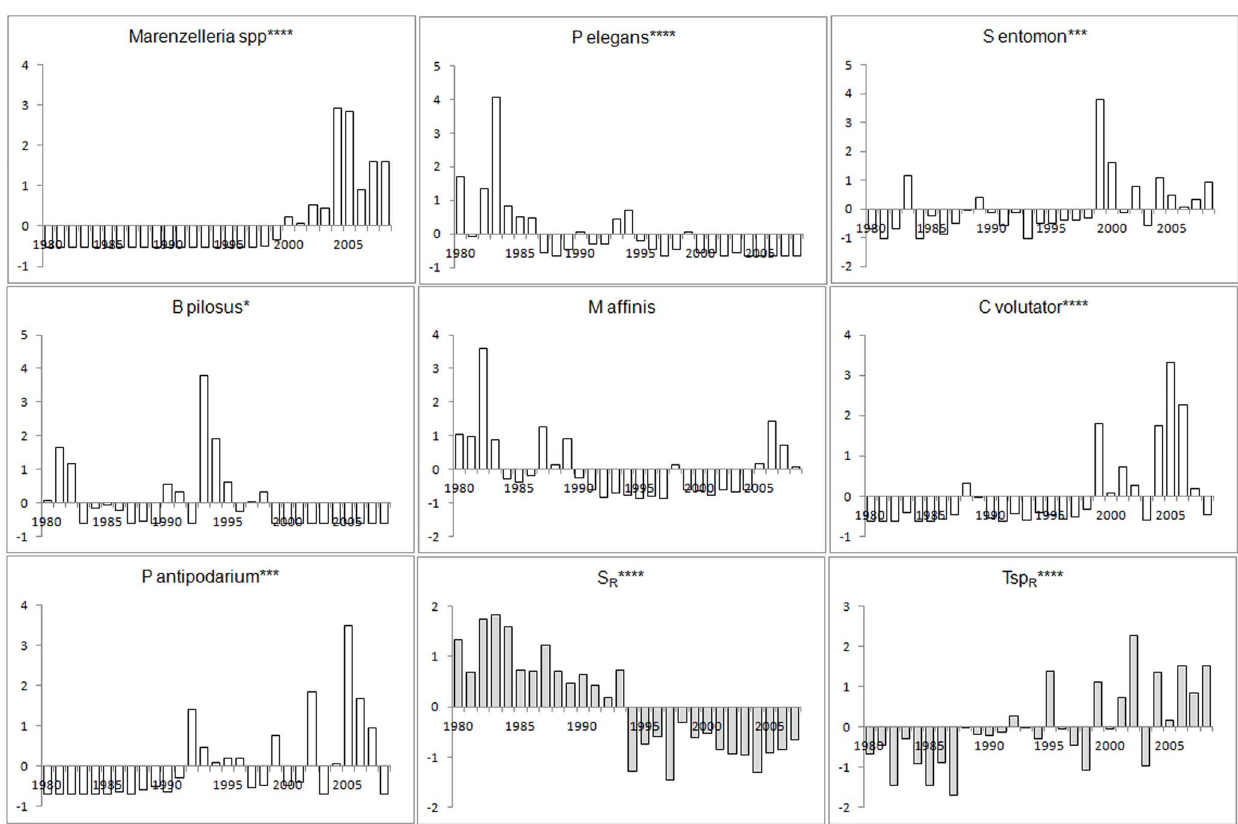
Figure 3. Development of species and variables contributing to temporal change community in community composition in Forsmark. The species presented (white bars) are those exhibiting a multiple metric correlation . 0.2 with any of the first two ordination-axes of the PCO-analysis for each data set and the variables (grey bars) associated with community development according to the DISTLM analyses. The annual value of each species and variable is presented as the standardised deviation from the average value during the whole time-series. For abbreviations of species names and environmental variables see table 1 and 3 respectively. * denotes a significant linear trend at a =0.05, *** a =0.001 and **** a =0.0001.